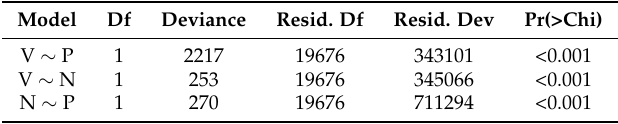
Table 4. Analysis of deviance generalized linear (Poisson) model of aggressive predator (P), prey (V), and non-aggressive adult (N) abundance within visual transects. Model: V predicted by P, V predicted by N, and N predicted by P.